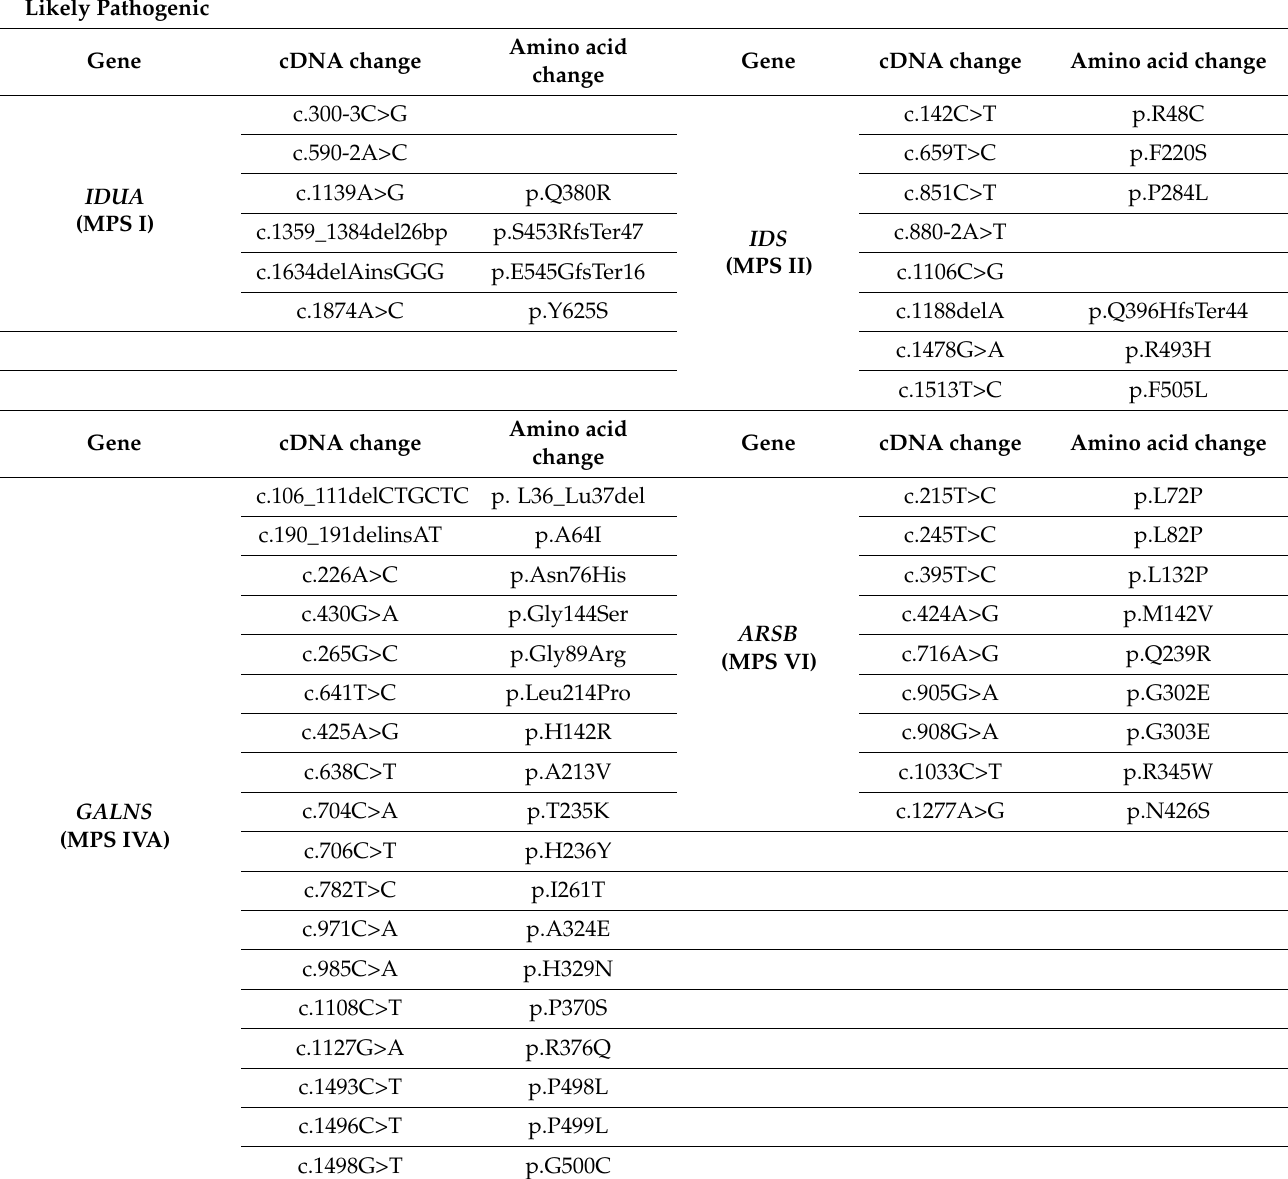
Table 2. Likely pathogenic variants of MPS genes, i.e., IDUA , IDS , GALNS , and ARSB defined by the ACMG